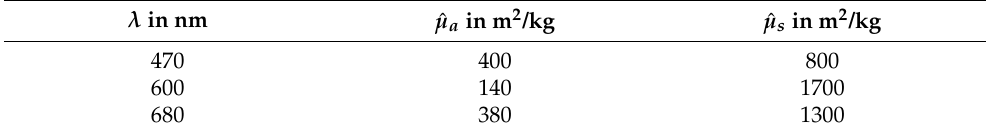
Table 1. Experimentally obtained absorption and scattering cross-sections of C. reinhardtii under optimal growth conditions. Data and notation are summarized from